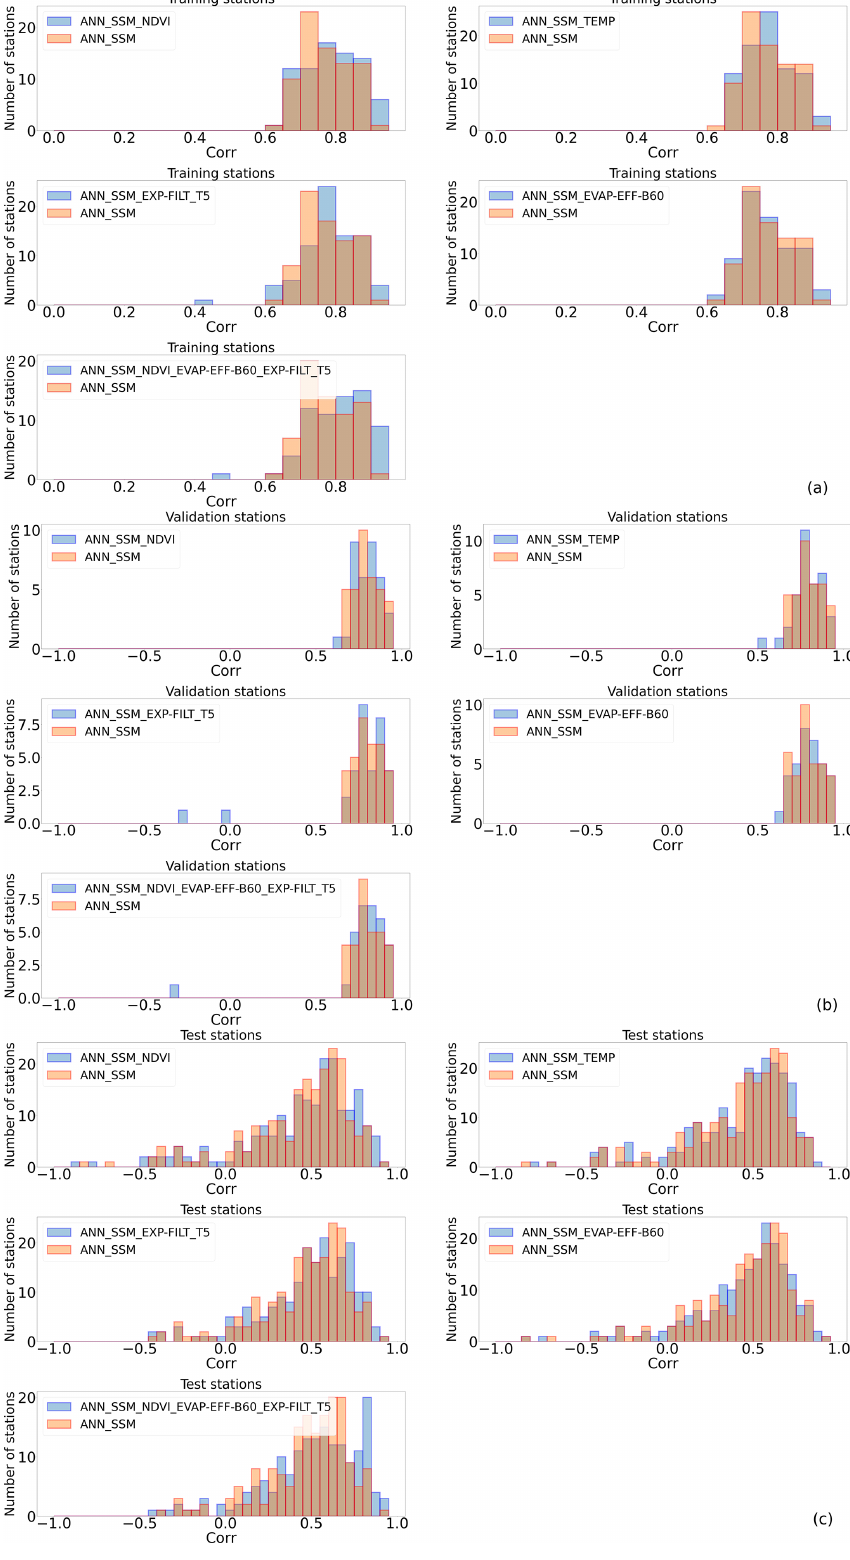
Figure 3. Correlation histograms of all tested ANN models compared to ANN_SSM (a) on training stations (b) , on validation stations (c) and on test stations (see Appendix D for RMSE